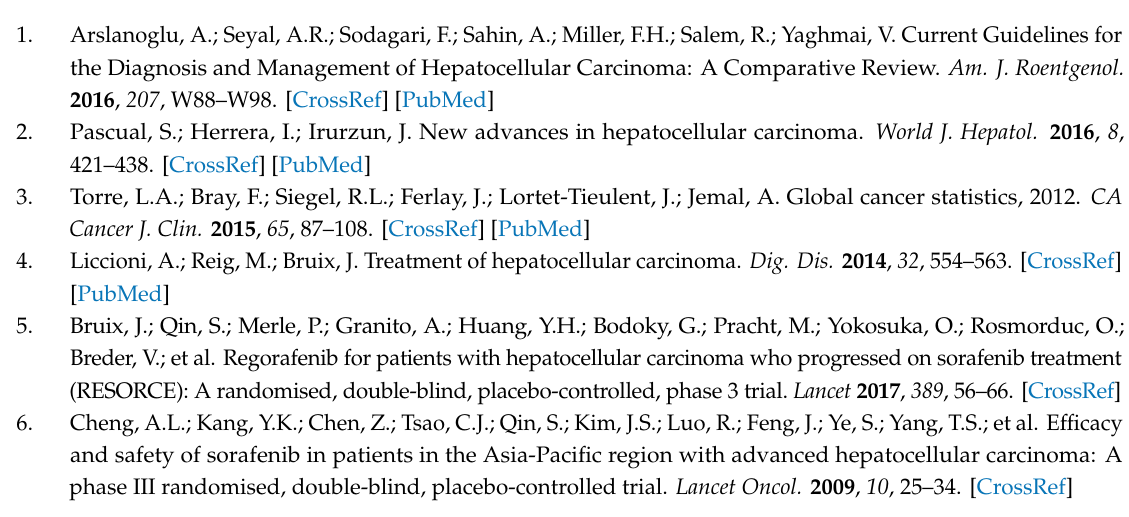
Table S1: Immunohistochemistry and western blotting antibody